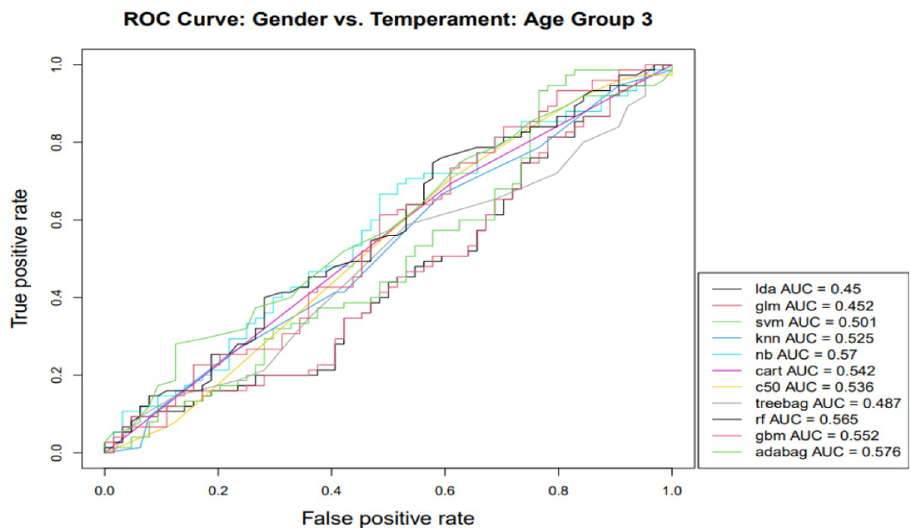
Fig 3. Note: lda—Linear Discriminant Analysis; glm—Generalized Linear Modeling; svm—Support Vector Machines; knn—K-Nearest Neighbor; nb—Na ï ve Bayes; cart—Classification and Regression Trees; c50—C5.0 Classification; treebag—Bootstrapped Aggregated Trees; rf—Ensembled Decision Trees (Random Forest); gbm— Gradient Boosting Method; adabag—Multi-class Adaptive Boosting (AdaBoost).